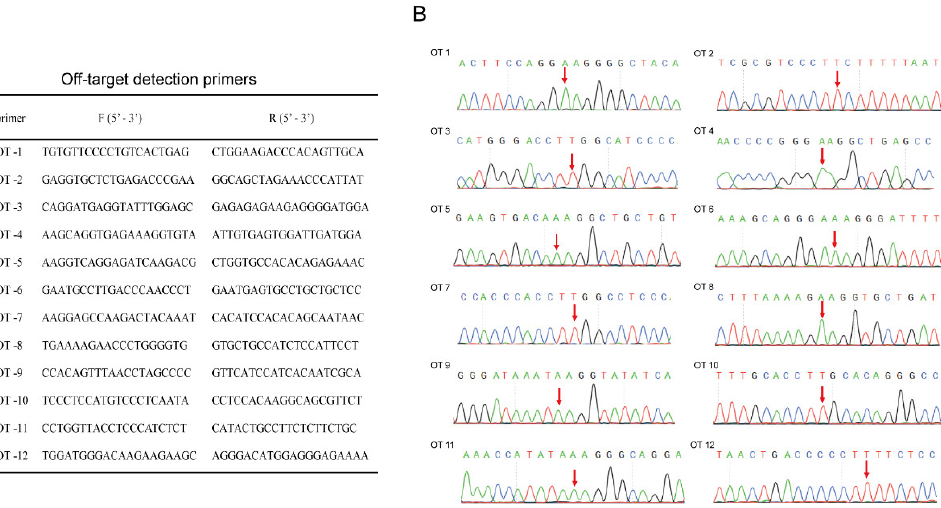
Figure 3. Off-target analysis of the cells with TERT promoter revertant mutations. ( A ) Primers for off-target analysis of the TERT promoter revertant mutation cells; ( B ) Sanger sequencing results of potential off-target sites of A375 -146C/C . Potential mutation locations are marked with red arrows. OT: off-target.